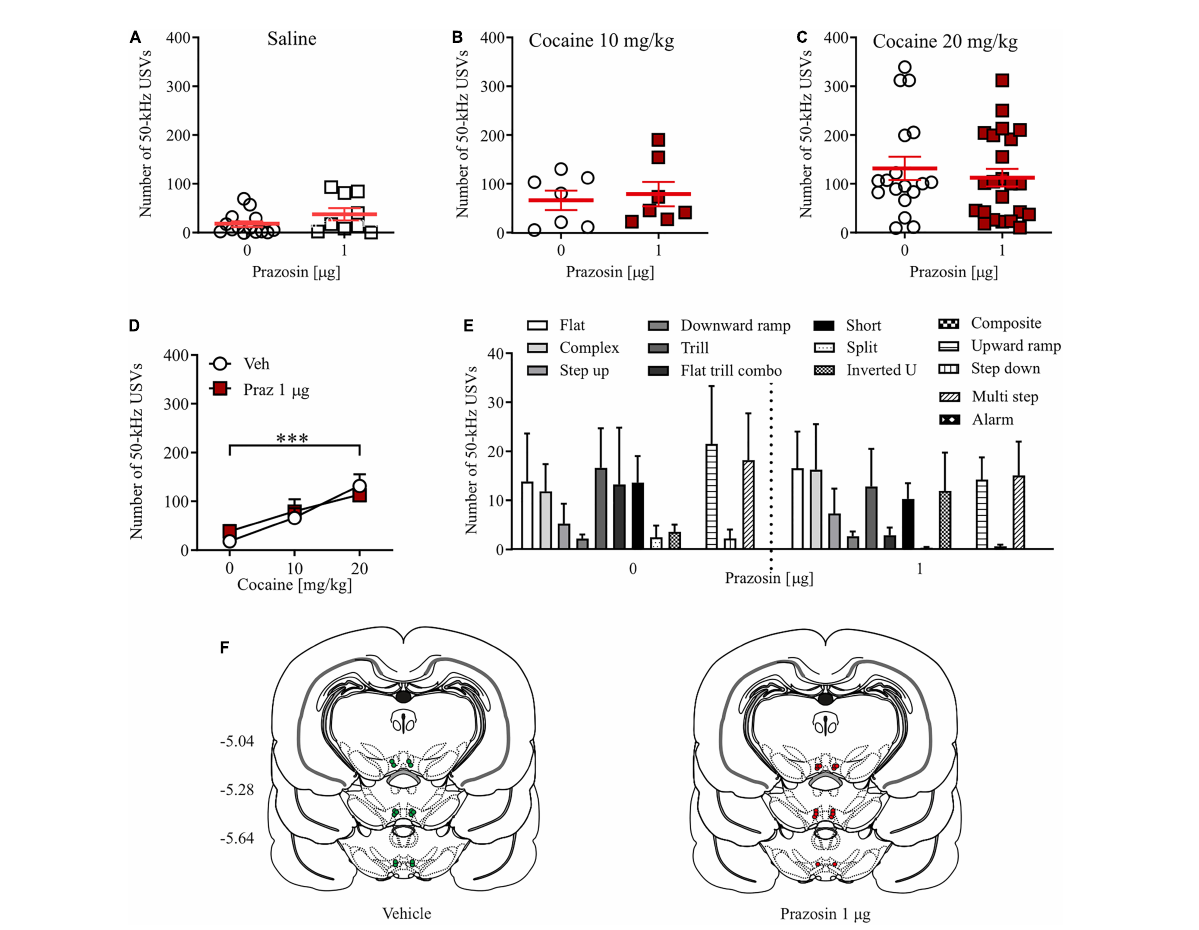
FIGURE3 Effects of α 1 -AR blockade in the VTA on cocaine-evoked 50-kHz USVs. α 1 -AR blockade in the VTA with 1 µ g/side prazosin (Praz) had no effect on the number of appetitive USVs after (A) saline (i.p.) or cocaine administration at (B) 10 mg/kg, i.p. or (C) 20 mg/kg dose. (D) Intra-VTA prazosin infusion had no effect on the cocaine-induced increase in the number of appetitive USVs and (E) did not modulate selected categories USVs after cocaine (20 mg/kg, i.p.) administration. (F) Localization of histologically verified cannula placements. Data are presented as individual data points as well as the mean and SEM. ∗∗∗ p < 0.001, Newman–Keuls post-hoc test vs. Cocaine 0 mg/kg.